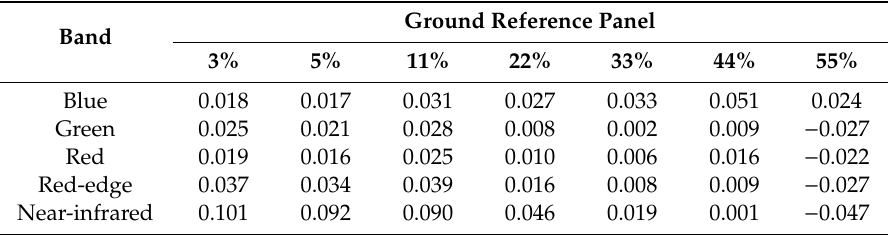
Table 1. Mean differences of reflectance between the reflectance map and the ground reference panels.